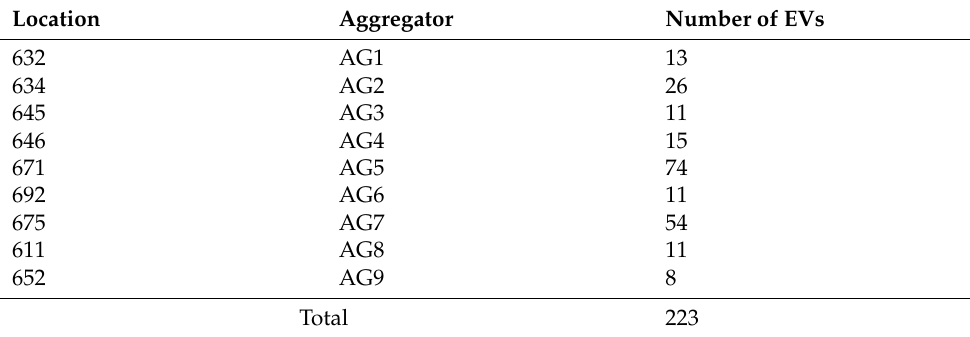
Table 1. EV penetration in the IEEE 13-node